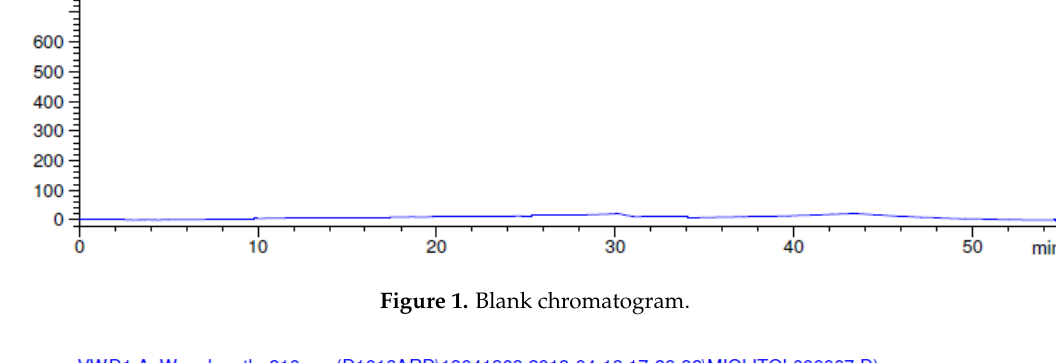
Figure 1. Blank chromatogram.